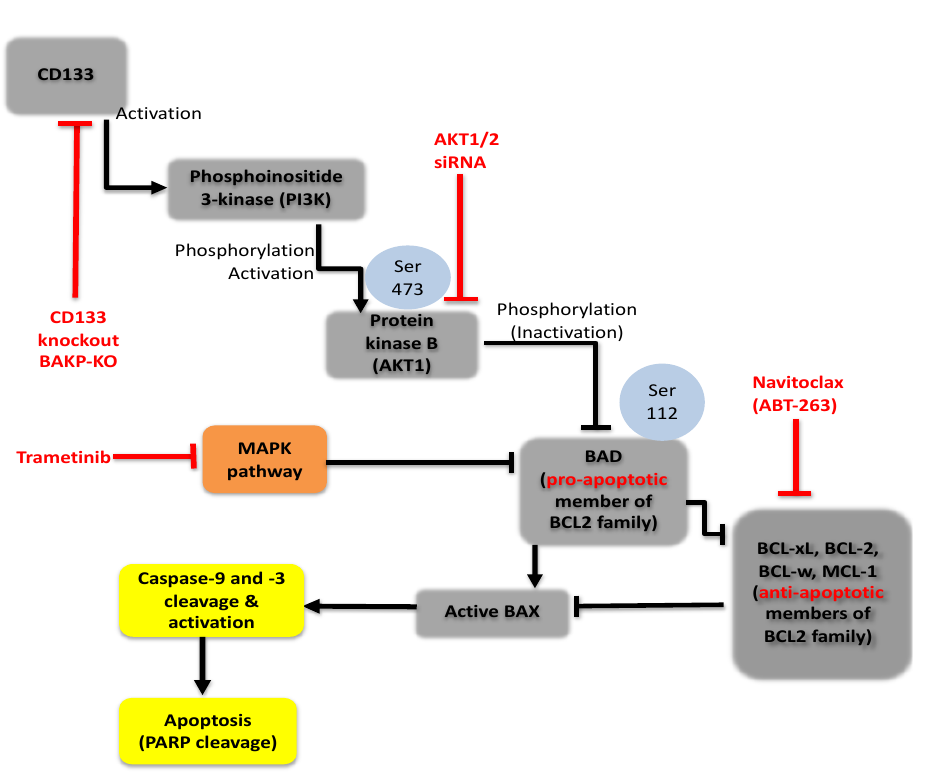
Figure 8. PI3K/Akt/ Bcl2 family pro-survival signaling pathway in CD133-positive melanoma initiating stem cells (MICs). CD133 may activate a survival pathway where (1) increased phosphorylation of AKT induces (2) phosphorylation and inactivation of BAD, (3) decreases the active form of BAX, and (4) reduces caspase activation and caspase-mediated PARP cleavage, indicating apoptosis suppression leading to drug resistance in melanomas.